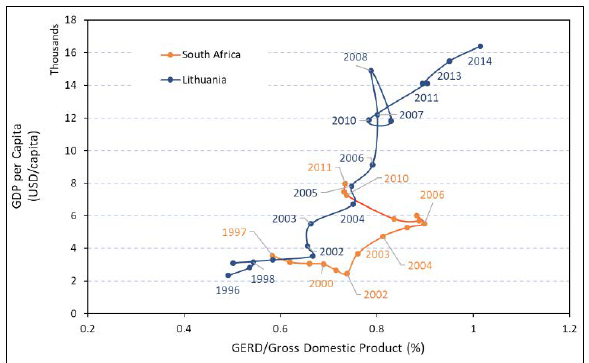
figure 2: Gross expenditure on research and development (GERD) and per capita income for South Africa and Lithuania, 1994 to 2016.